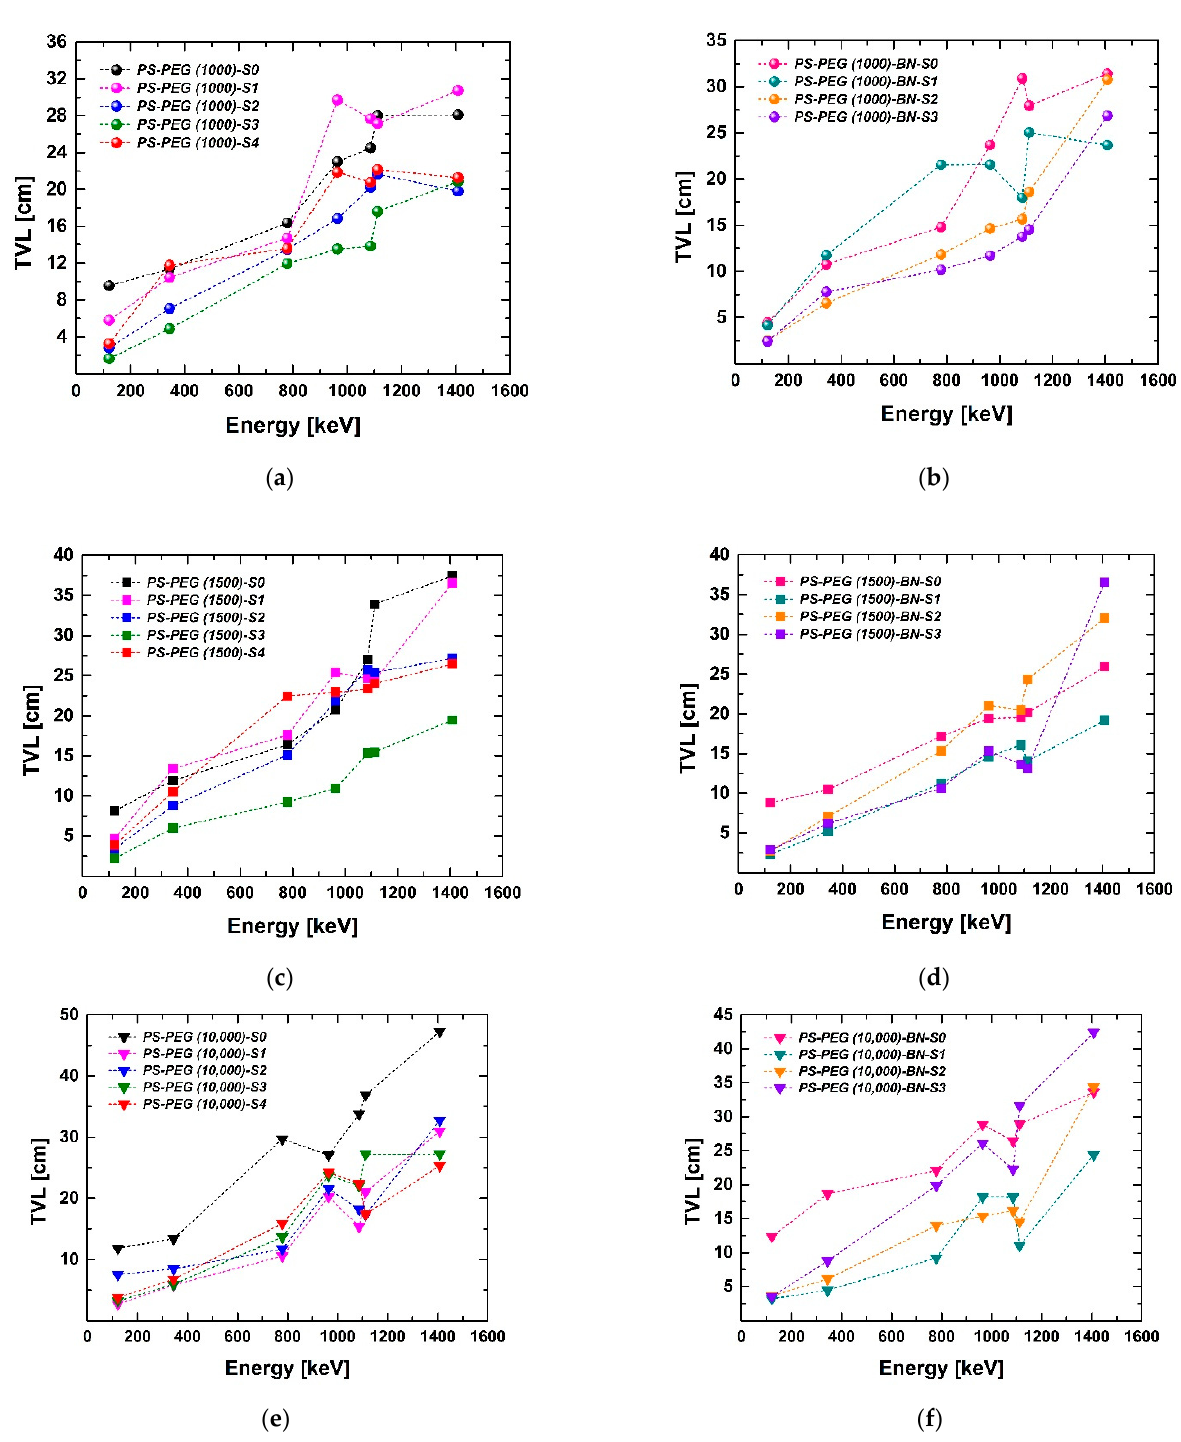
Figure 9. The TVL values of the PbO doped the crosslinked PS-b-PEG block copolymers and the PbO doped the PS-b-PEG-BN nanocomposite materials at different gamma radiation energies (from 121.782 keV to 1408.006 keV) of 152 Eu : ( a ) PS-PEG (1000)-S0,S1,S2,S3,S4; ( b ) PS-PEG (1000)-BN-S0,S1,S2,S3; ( c ) PS-PEG (1500)-S0,S1,S2,S3,S4; ( d ) PS-PEG (1500)-BN-S0,S1,S2,S3; ( e ) PS-PEG (10,000)-S0,S1,S2,S3,S4; ( f ) PS-PEG (10,000)-BN-S0,S1,S2,S3.